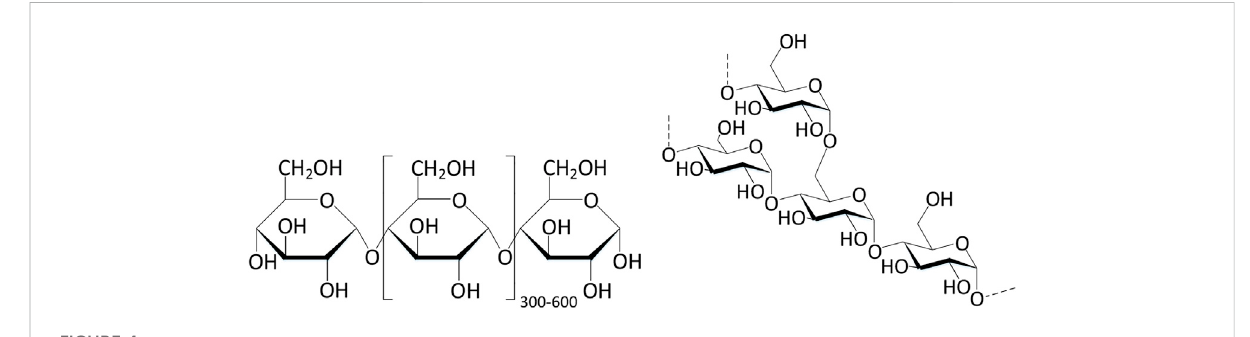
FIGURE 4 Molecular structure of starch (left: amylose; right: